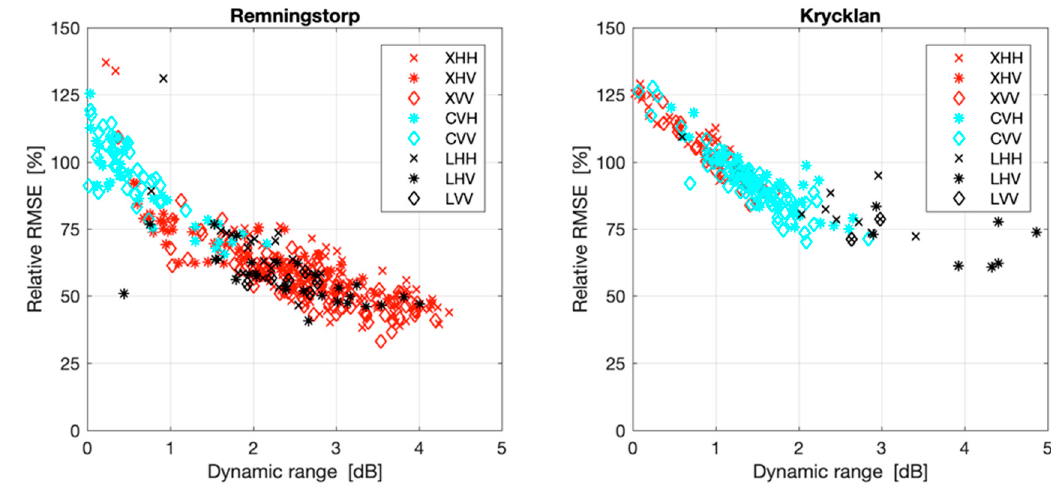
Figure 6. Relative root mean square error (RMSE) as a function of dynamic range at Remningstorp (left) and Krycklan (right).